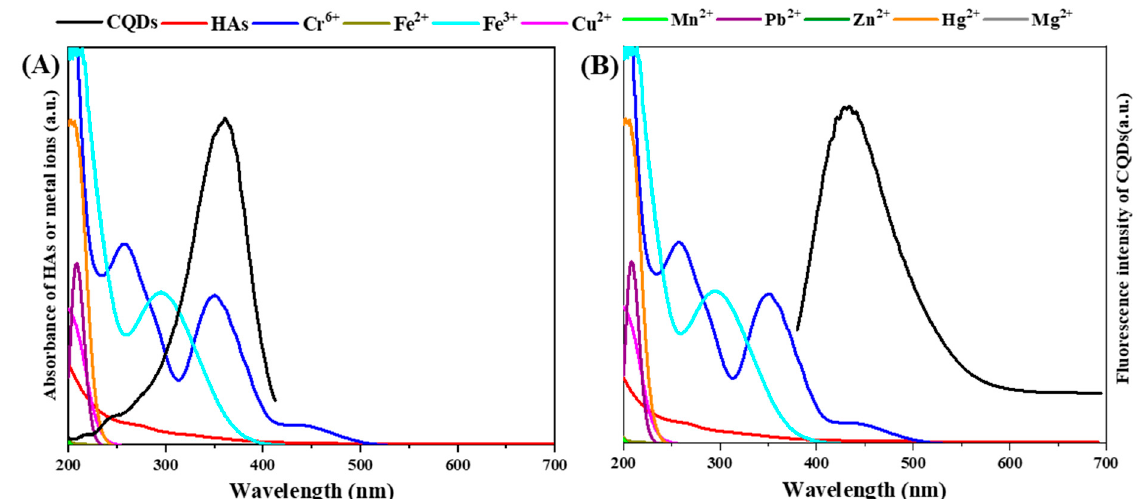
Figure 2. ( A ) The overlaps of the excitation spectrum of the cyanobacteria carbon quantum dots (CQDs) from 200 to 400 nm with emission wavelength at 430 nm with the absorption spectrum of humic acids (HAs) and metal ions. ( B ) The overlaps of the emission spectrum of CQDs from 380 to 700 nm with excitation wavelength at 360 nm with the absorption of HAs and metal ions.